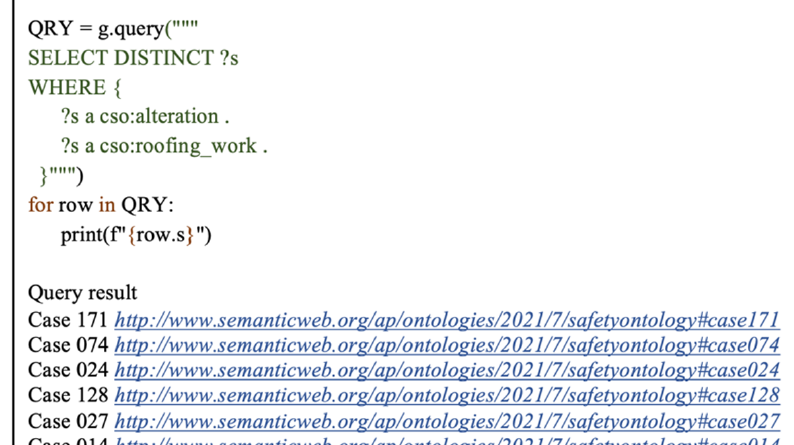
Figure 9. Query 2 code, result, and example of retrieved case.